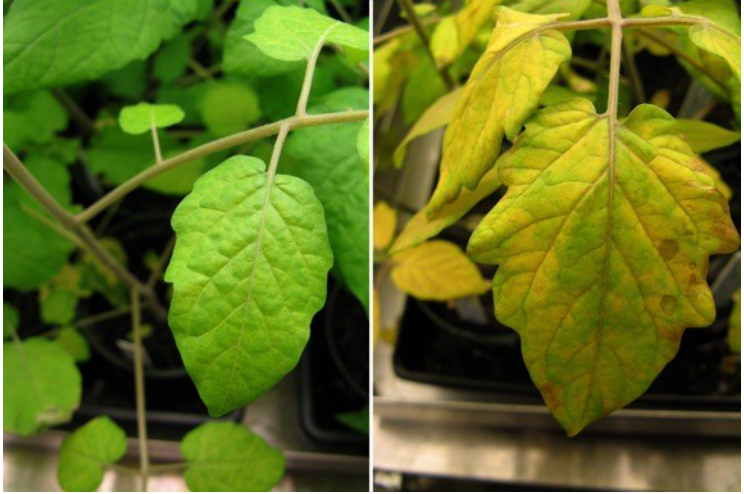
Figure 1. Example of a control tomato plant ( left ) compared to a contaminated tomato plant ( right ) grown under the same conditions for the same time